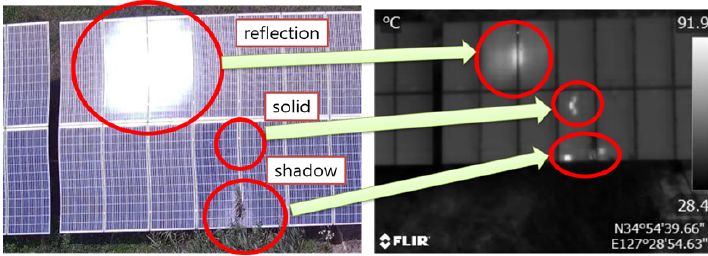
Figure 15. Hotspots caused by unknown reason: 98.6 °C.